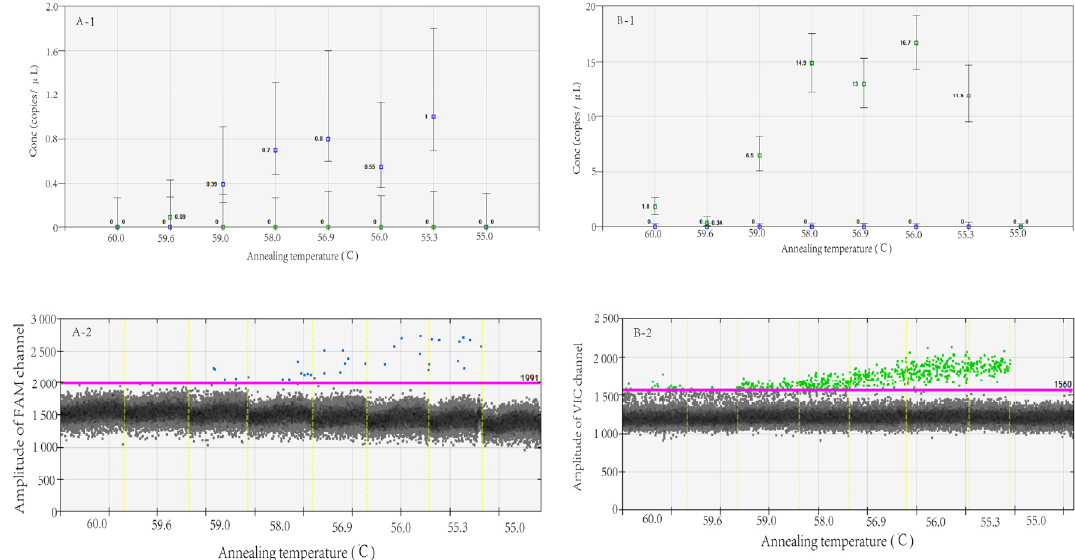
Figure 1. MT ( A )- and WT ( B )-type plasmids detected by RT-dd PCR at different annealing temper- atures. Note: The X-axis of A-1 , B-1 , A-2 and B-2 indicates different amplification annealing temper- atures; the Y-axis of A-1 and B-1 indicates the number of gene copies per microliter of reaction sys- tem for FAM and VIC channels, the Y-axis of A-2 and B-2 indicates the amplitude of FAM and VIC